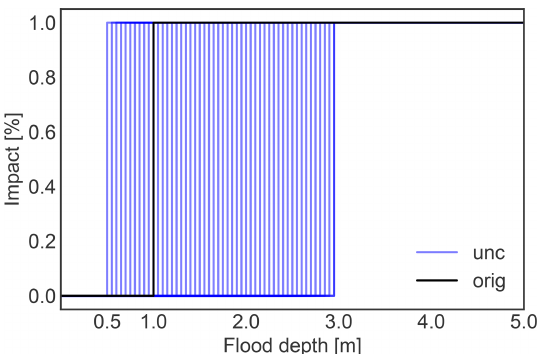
Figure D2. Impact function uncertainty, with a threshold shift of the flood depth above which all people are affected varying between 0 . 5 and 3m (cf. Table 1). The original impact function is given in black.